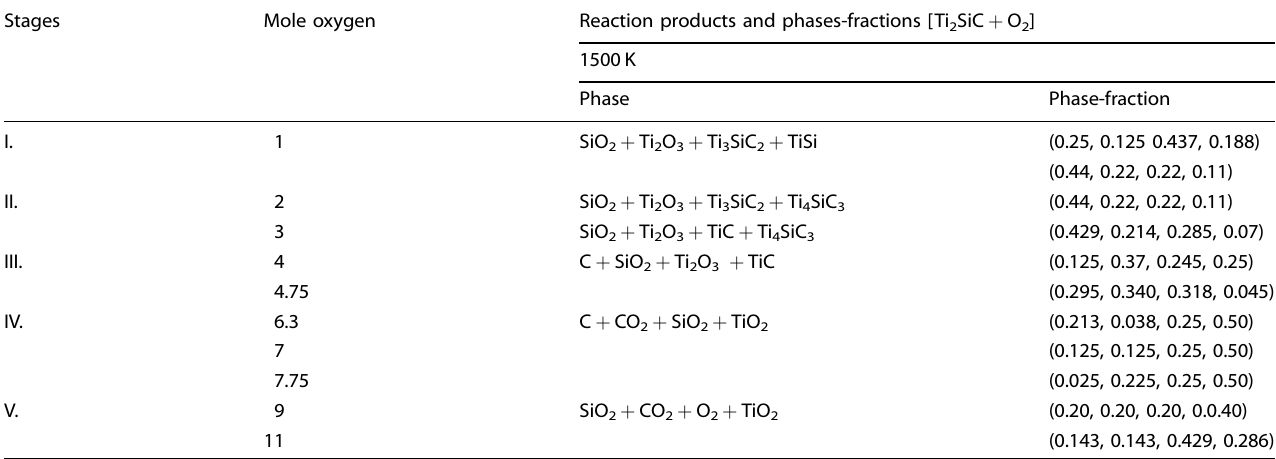
Table 1. Predicted set of thermodynamically favored reaction products in Ti 2 SiC + O 2 at reaction temperature of 1500 K. Stages Mole oxygen